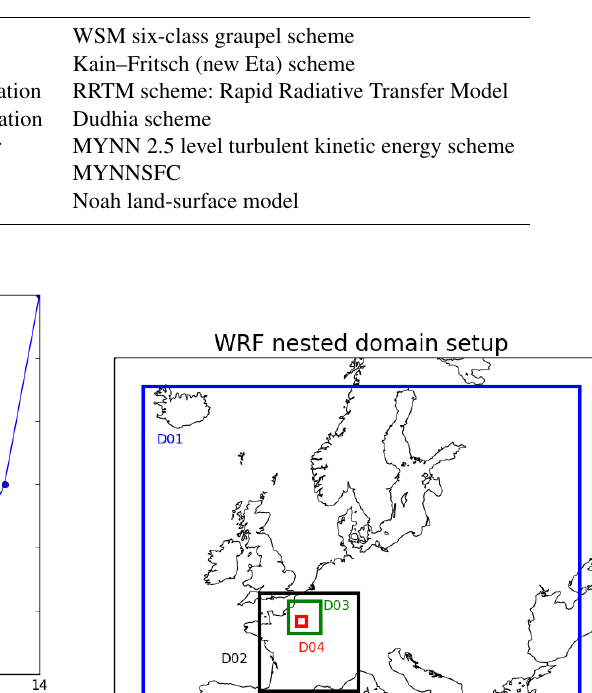
Figure 1. Regional-scale domains: Europe (domain 1, with a spatial resolution of 45km × 45km), France (domain 2, with a spatial resolution 9km × 9km) and the Île-de-France region (domain 3, with a spatial resolution 3km × 3km) for one-way nesting simulations using Polair3D, as well as Paris (domain 4, with a spatial resolution of 1km × 1km) for simulations with SinG. Table 1. Main physical options used in WRF simulations.